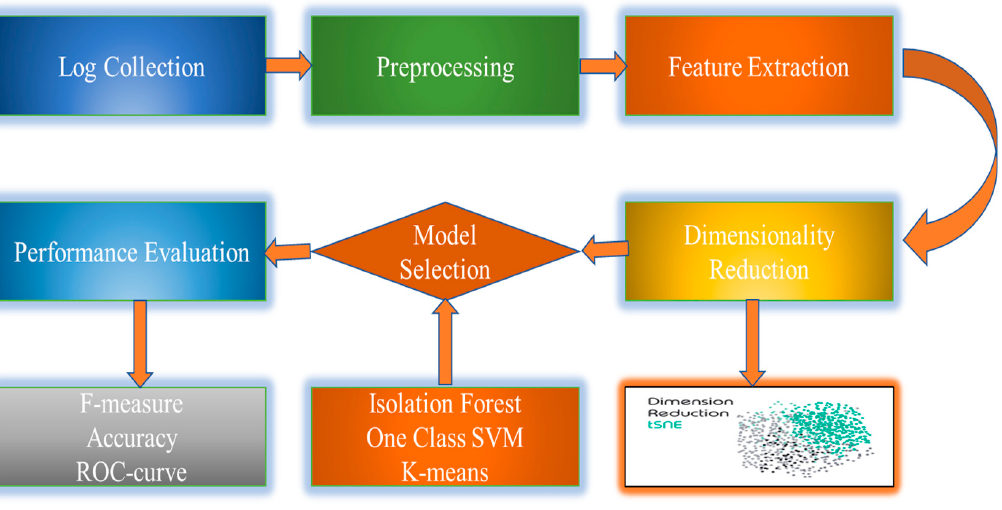
Figure 7. Workflow of the proposed method.